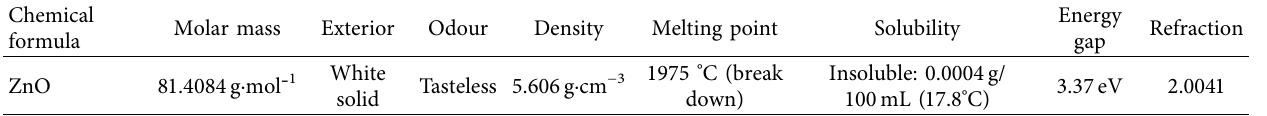
Table 1: Properties of zinc